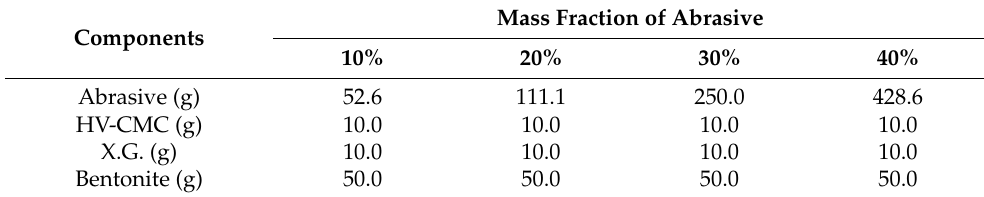
Table 3. The compositional mass of the slurry in the test [26].